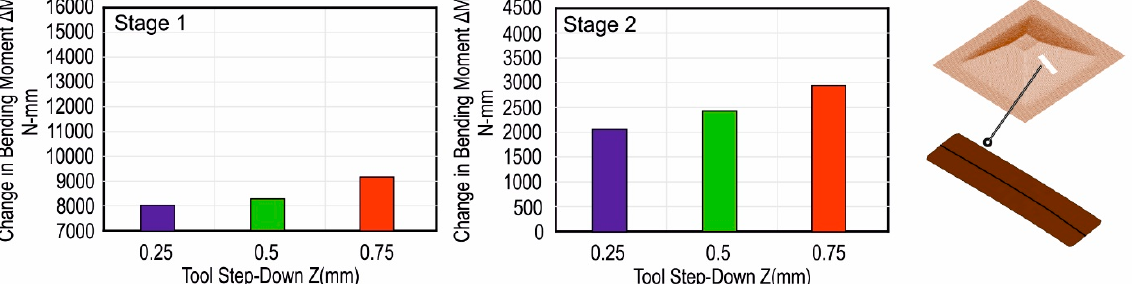
Figure 10. Change in the bending moment for different tool step-down upon unclamping (Stage 1) and upon trimming (Stage 2) along a section.